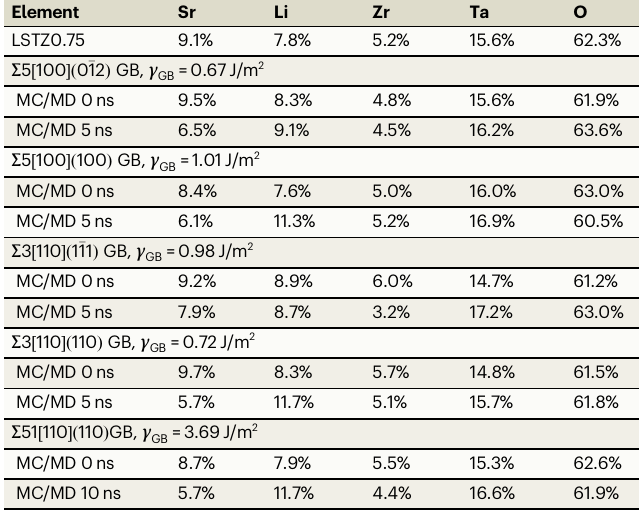
Table 1 | Local composition of the GB regions in the fi ve GB models before and after MC/MD simulations at 1573 K Element Sr Li Zr Ta O LSTZ0.75